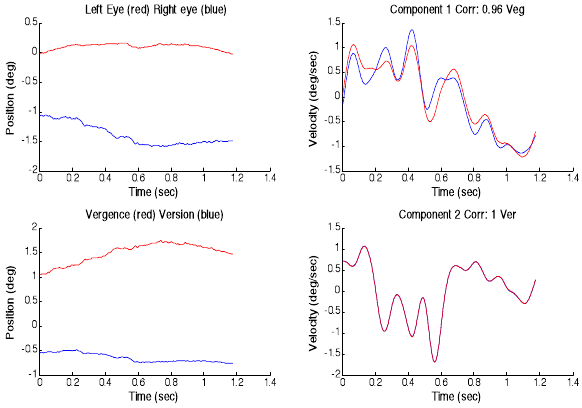
Figure 4 The fusion sustainning portion of the response to a pure vergence step stimulus plotted as both left and right eye movements (upper left) and version and vergence responses (lower left). The best matching unmixed velocities are shown as blue traces on the right side.